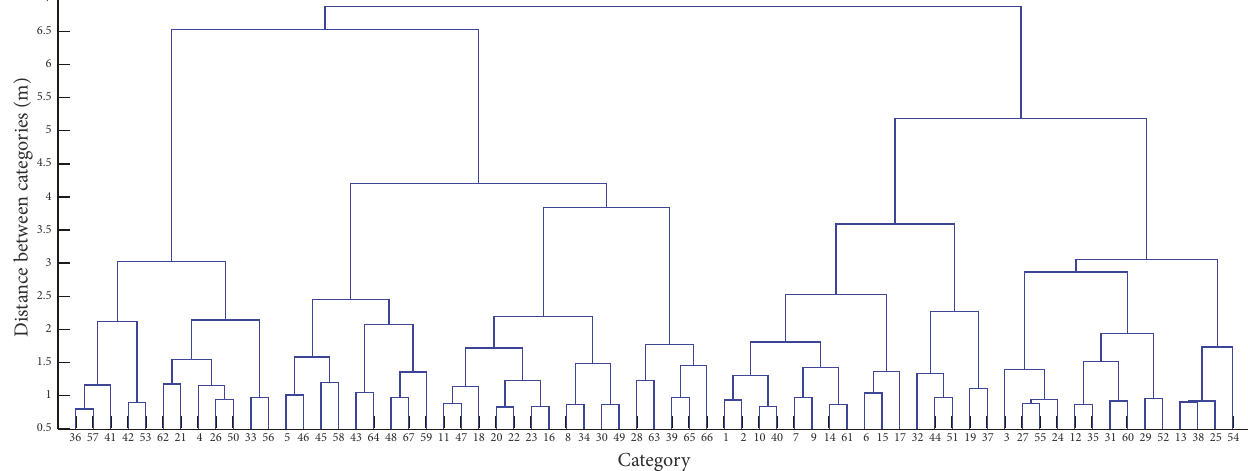
Figure 7: Destination hierarchical clustering tree.